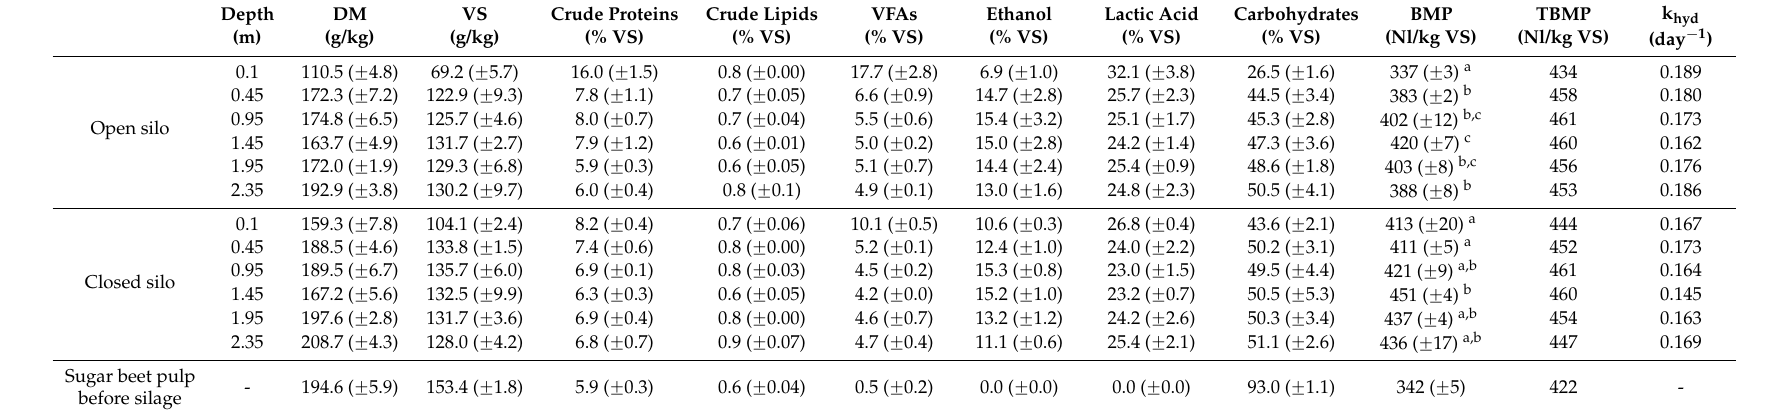
Table 1. Organic composition, methane yield and hydrolysis kinetic constants of experiments for open and closed silos.